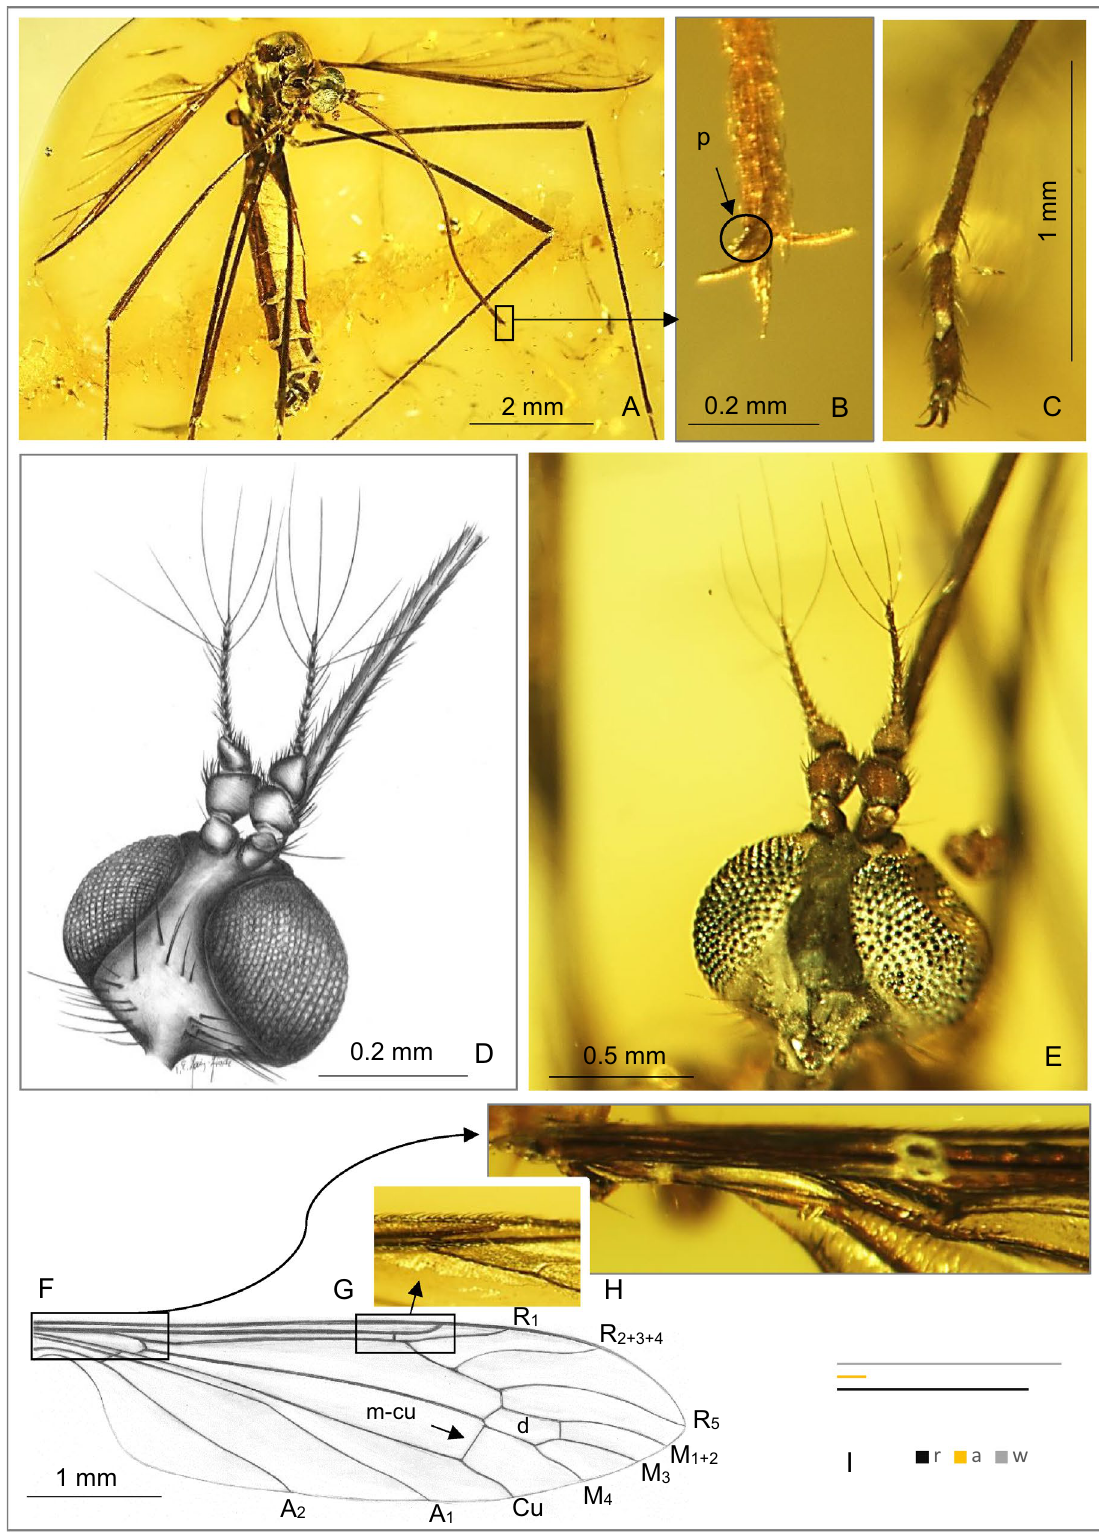
Figure 1. Toxorhina ( Ceratocheilus ) eridanus Meunier 5 (Limoniidae), inclusions in Baltic amber, ( A – E , G , H )—No. CCHH 832-1 (male) (coll. Ch. and H. W. Hoffeins), specimen from Senckenberg Deutsches Entomologisches Institut (SDEI) Müncheberg, Germany: ( A ) body, dorso-ventral view; ( B ) enlarged view of the tip of rostrum with palpus visible; ( C ) last tarsomeres; ( D ) drawing of head with part of rostrum, latero-dorsal view (reconstruction); ( E ) photograph of head with part of rostrum, latero-dorsal view; ( F )— No. K2532 (male) (coll. Klebs), specimen from University of Göttingen, drawing of wing (reconstruction); ( G ) photograph of enlarged view of sc-r position; ( H ) photograph of enlarged view of base of wing; ( I ) relation between the length of rostrum (r), antenna (a) and wing (w).